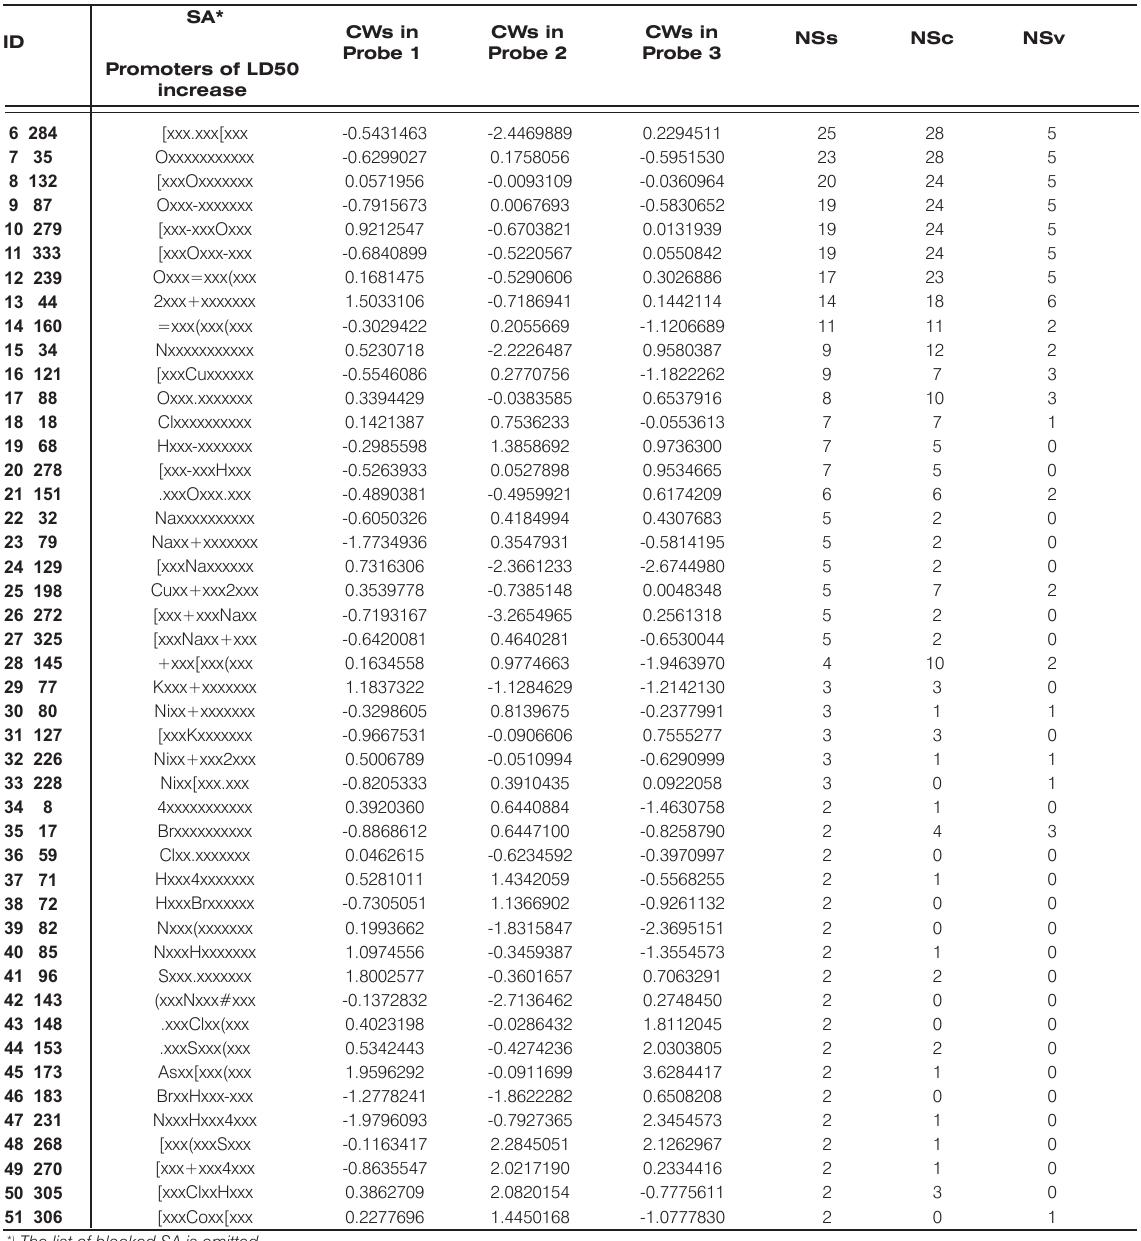
Table 2. Correlation weights of SMILES attributes (SA) which have been obtained for split A using the threshold 2. ID contains two Contiuned integers: the first is numbering for the given category; the second is the number of SA in the general list of SA for all